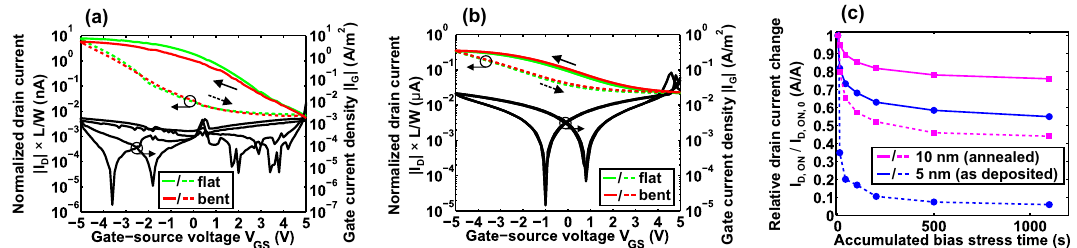
Figure 6. Bending and bias stress measurements. ( a ) Transfer characteristic of a TFT with a 5-nm-thick amorphous (as deposited) GST channel under bending (radius R = 6 mm). ( b ) Transfer characteristic of a TFT with a 10-nm-thick crystallized (annealed) GST channel under bending (radius R = 6 mm). ( c ) ON-current I D,ON change upon bias stress. The dashed lines represent I D,ON directly after bias stress and the solid lines correspond to I D,ON after a sweep to positive V GS